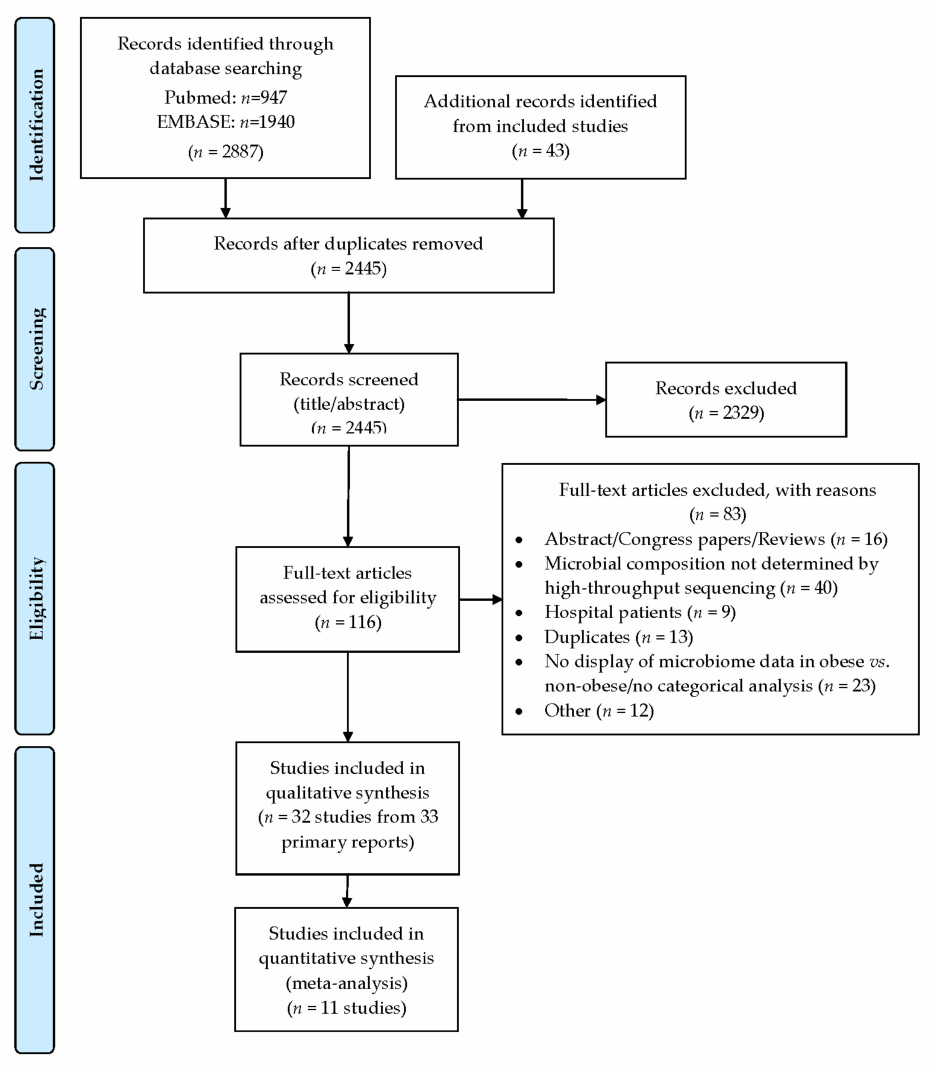
Figure 1. Description of the selection of the included studies following a PRISMA flow